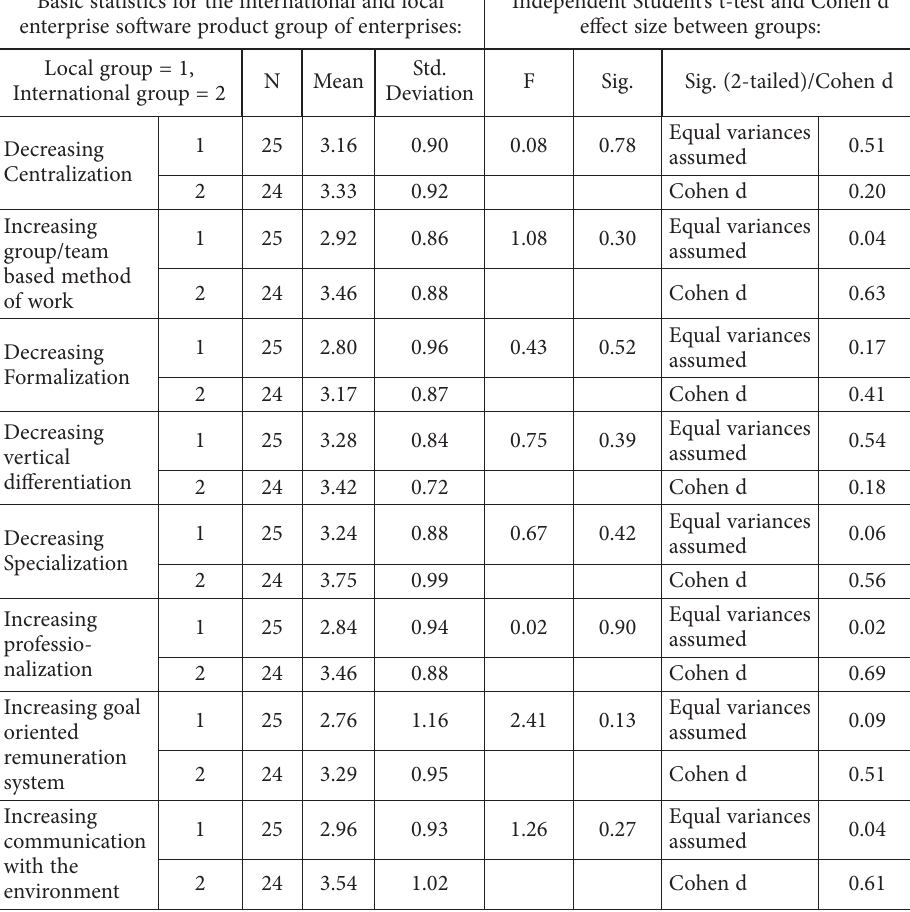
Table 4. The comparison of strategic characteristics between the enterprises that predominantly invest in pre-configured software products and those that predominantly invest in custom software products Basic statistics for the international and local Independent Student’s t-test and Cohen d enterprise software product group of enterprises: effect size between